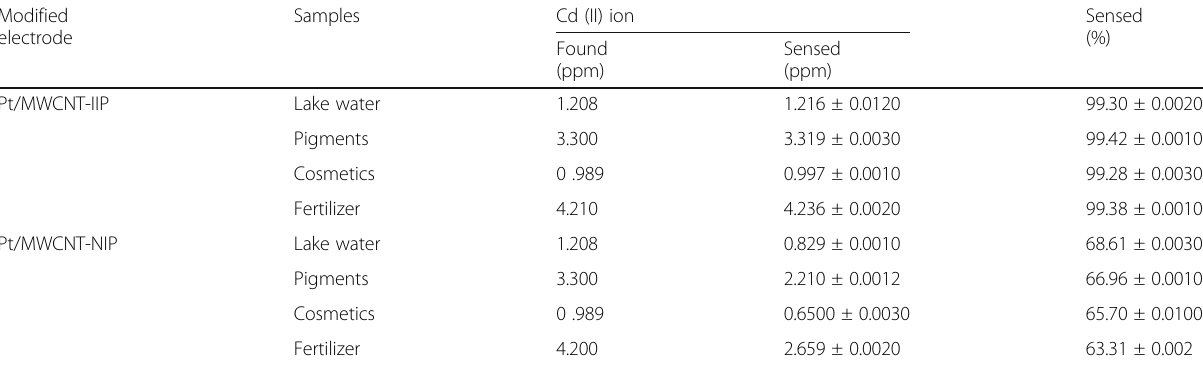
Table 2 Sensing of Cd(II) ion in real samples by the modified electrode Modified